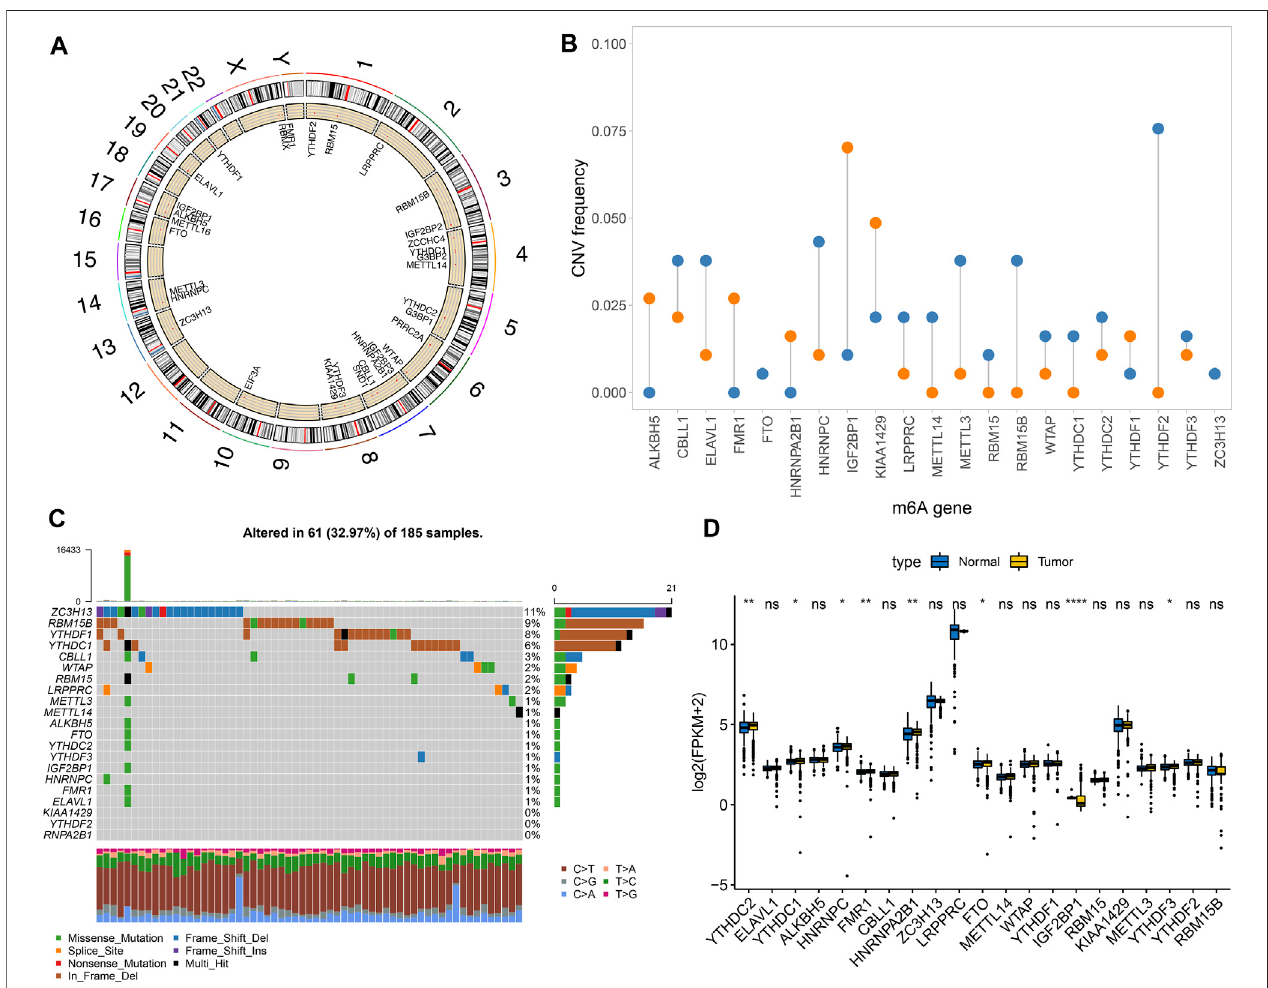
FIGURE 1 | Landscape of genetic mutation and expression patterns of m 6 A regulators in pancreatic cancer. (A) The locations of m 6 A regulators on the chromosomes. (B) The distribution of CNV frequency of m 6 A regulators. Blue indicates deletion and orange indicates ampli fi cation. The height of bar indicates the variation frequency. (C) Landscape of somatic mutation of m 6 A regulators. (D) Box plot of expression patterns of m 6 A regulators in normal and pancreatic cancer. Ns: not signi fi cant; * p < 0.05; ** p < 0.01; **** p <